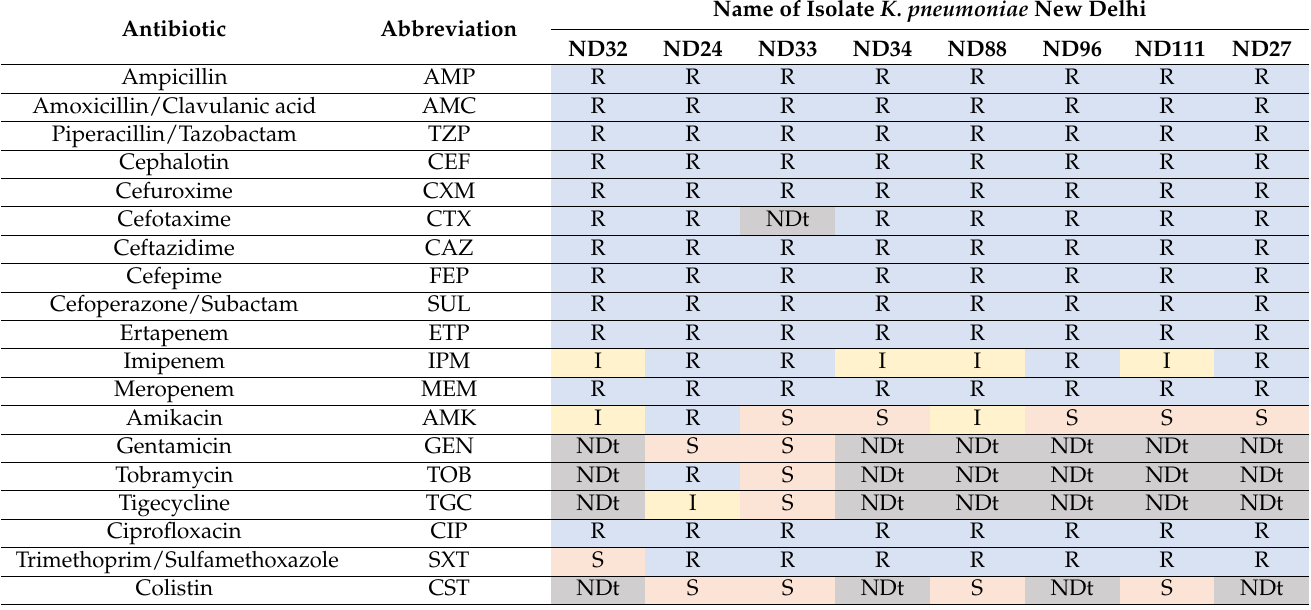
Table 2. Antibiotic susceptibility profiles for the tested K. pneumoniae strains.